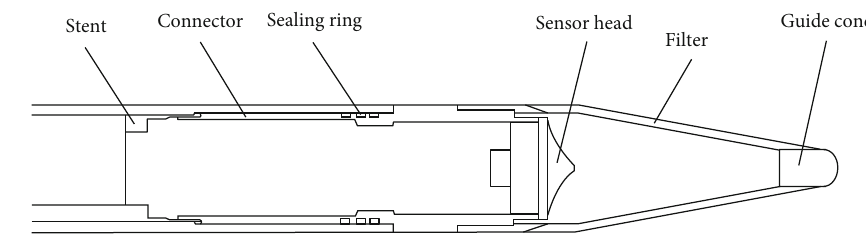
Figure 1: Schematic diagram of multiphase fl ow simulation well experiment device.